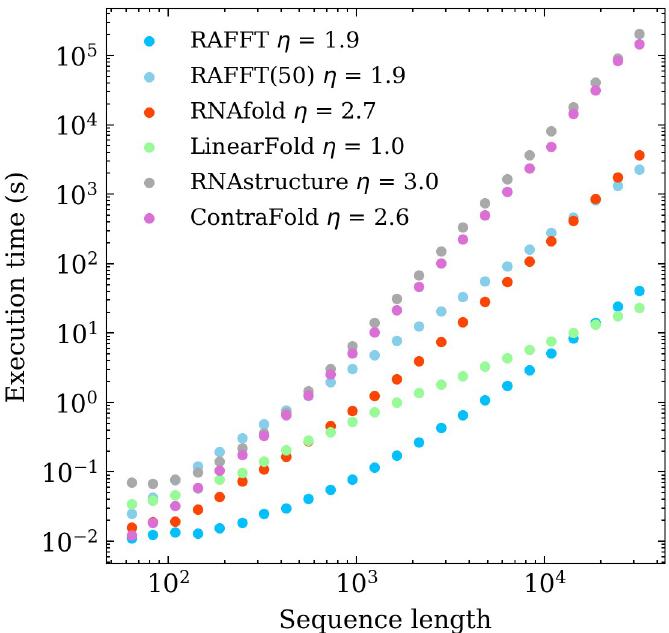
Fig 3. Fast folding graph constructed using RAFFT . In this example, the sequence is folded in two steps: starting from the unfolded structure, the N = 5 most stable stems found are stored in stack 1. From stack 1, multiple stems can be formed but only the N = 5 most stable are stored in stack 2. All secondary structure visualizations were obtained using VARNA [37].